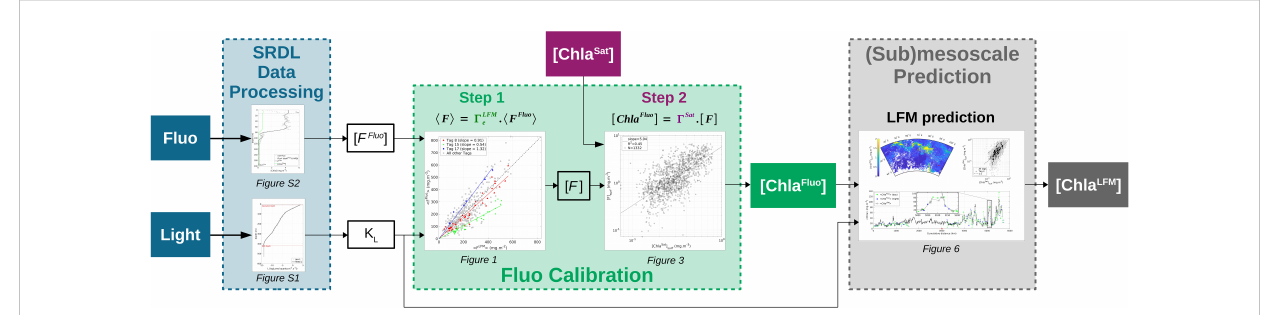
FIGURE 1 Flowchart summarizing the main steps of the method described in the present study. The method aims at enhancing the quality of the in-situ [Chla] estimates provided by a set of multiple bio-logging devices (SRDLs) in terms of accuracy and horizontal resolution. Based on SRDL data (Fluo and L in-situ measurements, blue boxes) combined with concomitant satellite estimates of [Chla] ([Chla Sat ], purple box), the method fi rstly enables the constitution of calibrated datasets of in-situ [Chla] estimates ([Chla Fluo ], green box). The method then extends the description of the [Chla] fi eld to (sub)mesoscale ([Chla LFM ], gray box) through the use of K L as a predictor for